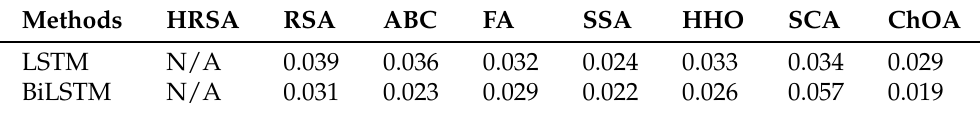
Table 11. p -values determined by the Wilcoxon signed-rank test on both problem instances.